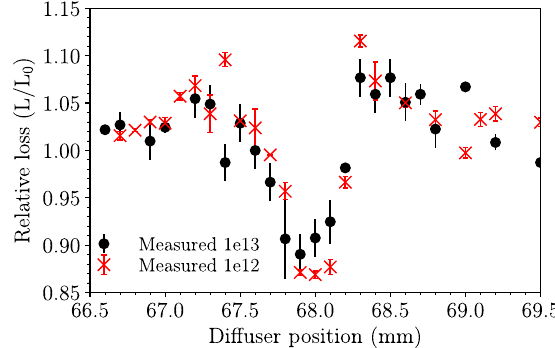
FIG. 11. Measured sum of extraction beam losses (normalized to losses with no diffuser present) for diffuser position scans with two different intensity